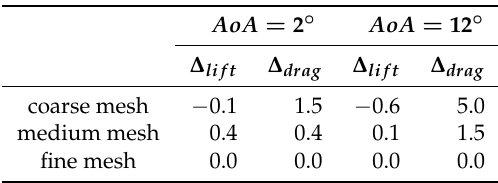
Table A2. Relative differences ∆ lift , ∆ drag in (%) of lift and drag coefficients compared to the coefficients resulting from the finest